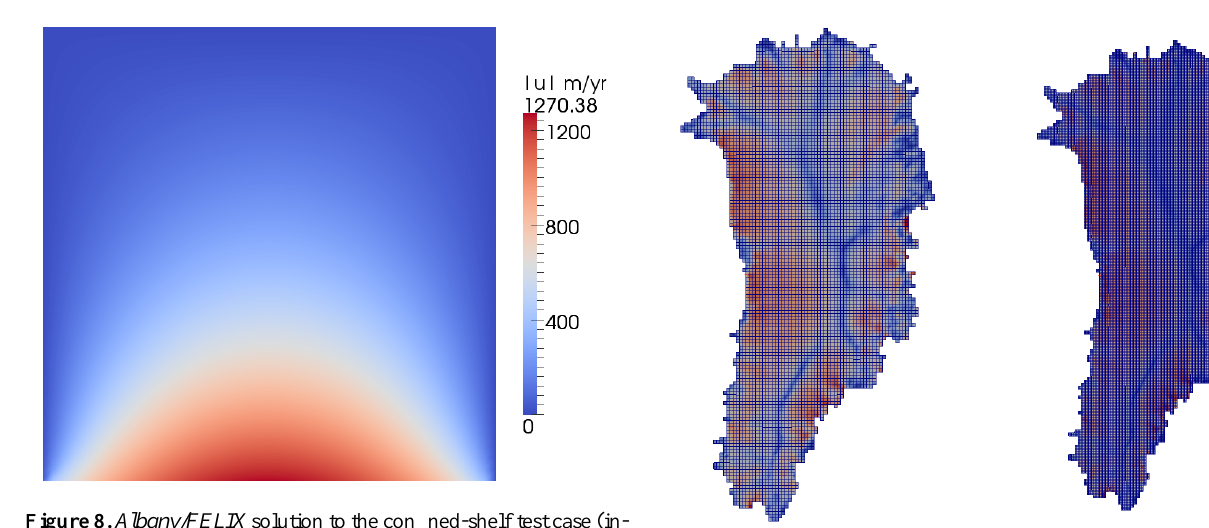
Figure 8. Albany/FELIX solution to the confined-shelf test case (in- distinguishable from the solution obtained by the solver of Perego et al. (2012)).